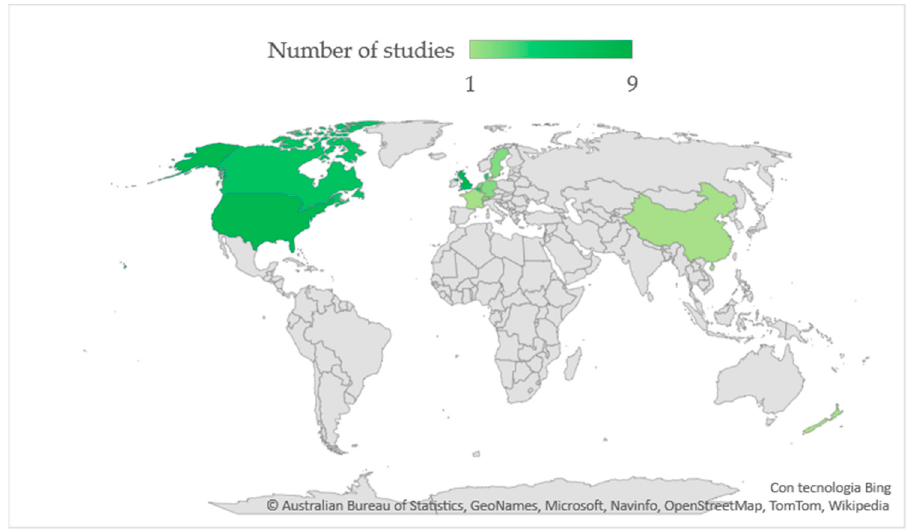
Figure 2. Countries where studies on dietary fibers were performed. The green indicates the number of studies performed in the different countries: the darker the green, the higher the number of studies conducted.